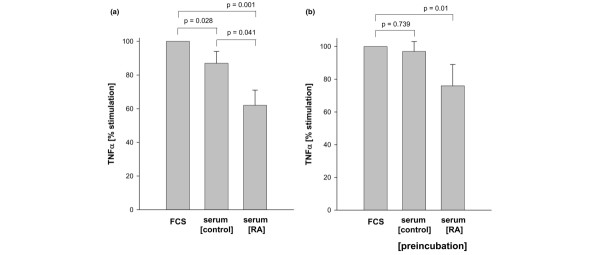
Sera from RA patients inhibit T cell-induced TNF-α production by monocytes from healthy donors. (a) Peripheral-blood T cells (106/ml) were cultured for 48 hours in the presence of immobilized anti-CD3 (3.3 μg/ml) and soluble anti-CD28 (0.8 μg/ml) antibodies. The cells were fixed and incubated for 24 hours with freshly isolated monocytes (1.5 × 106/ml) at a ratio of 7:1. The co-incubation assay was performed in the presence of 10% FCS, 10% serum from patients (serum [RA]) or from healthy donors (serum [control]). All data are expressed as percentages of TNF-α produced in the 10% FCS containing co-culture system (100%). Data are means ± SEM for 10 independent experiments; levels of significance are as indicated. (b) Monocytes from healthy donors were preincubated with 50% control sera (nine donors) or RA sera (six sera from patients with RA, which were previously found to inhibit T cell-dependent monocyte activation) and then washed thoroughly three times. Co-culture experiments were performed as described in the text in medium supplemented with 10% FCS. All data are expressed as percentages of TNF-α produced in the co-culture system containing 10% FCS. Data are means ± SEM for four independent experiments; levels of significance are as indicated.